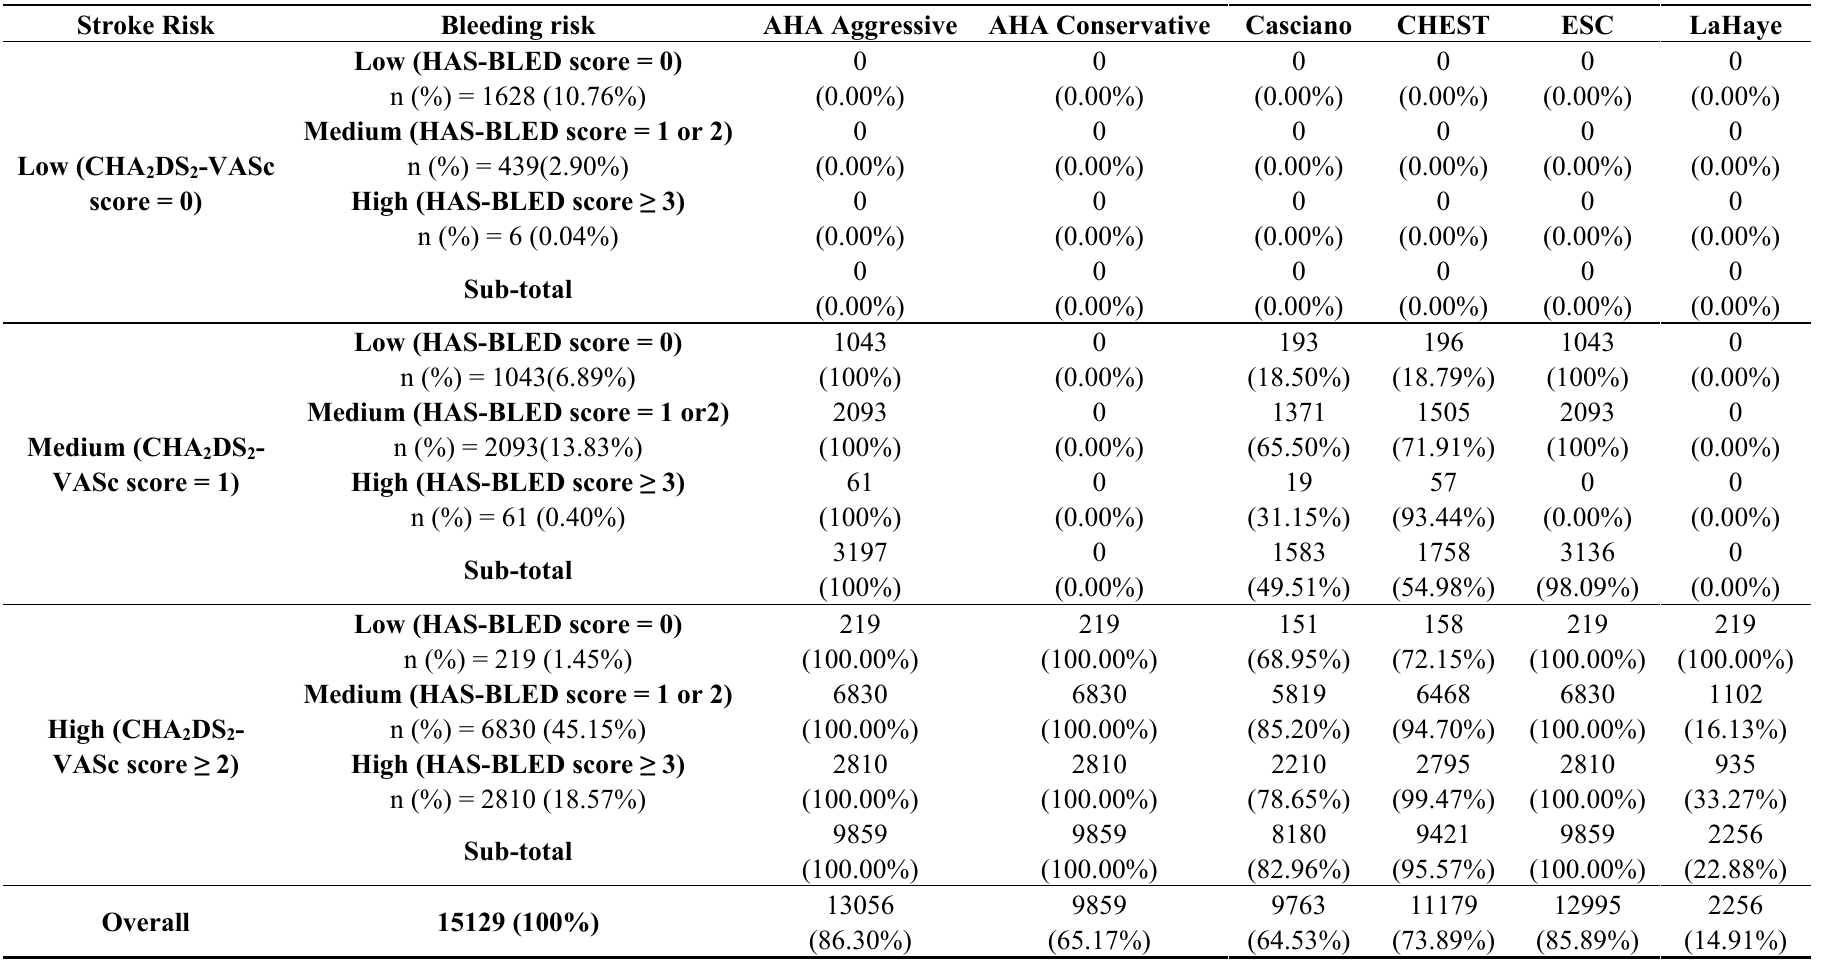
Table 2. Oral anticoagulation (OAC) recommendations by the decision